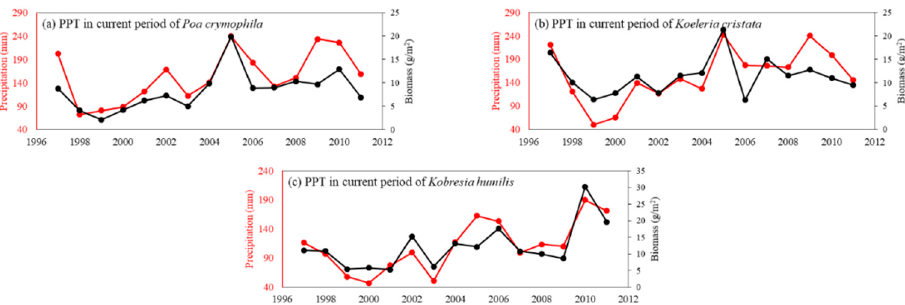
Figure A2. Trends of annual and monthly effective precipitation during 1997–2011. (a) Annual precipitation; (b) previous September precipitation; (c) April precipitation; (d) May precipitation; (e) June precipitation; (f) July precipitation; (g) August precipitation.